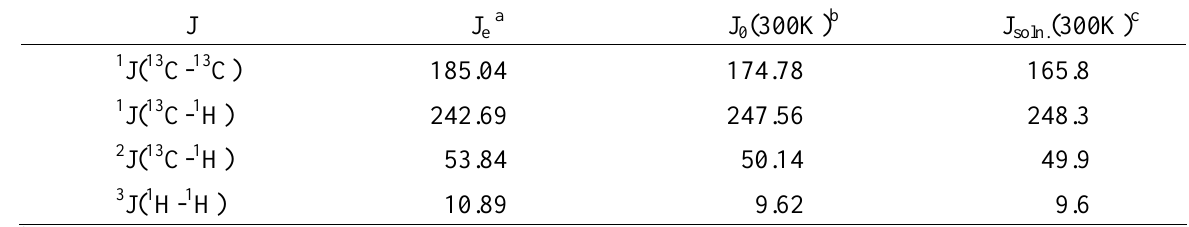
Table 1. Experimental spin-spin coupling constants for 1,2- 13 C-acetylene in Hz